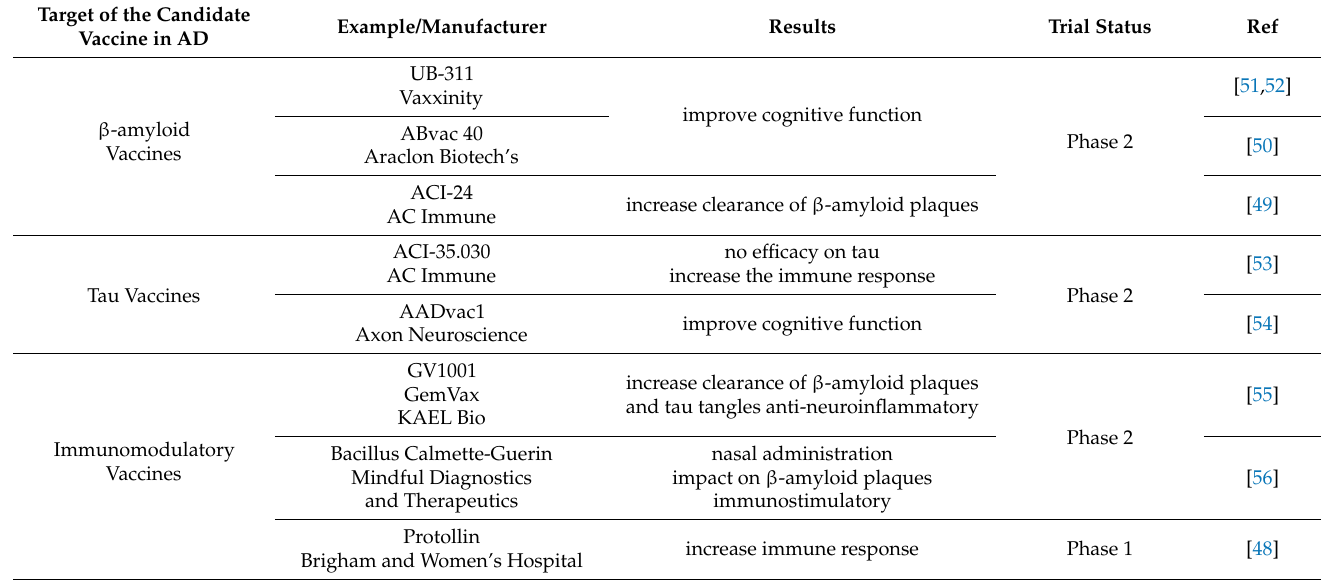
Table 1. Summarized data regarding the candidate vaccines for the potential treatment of